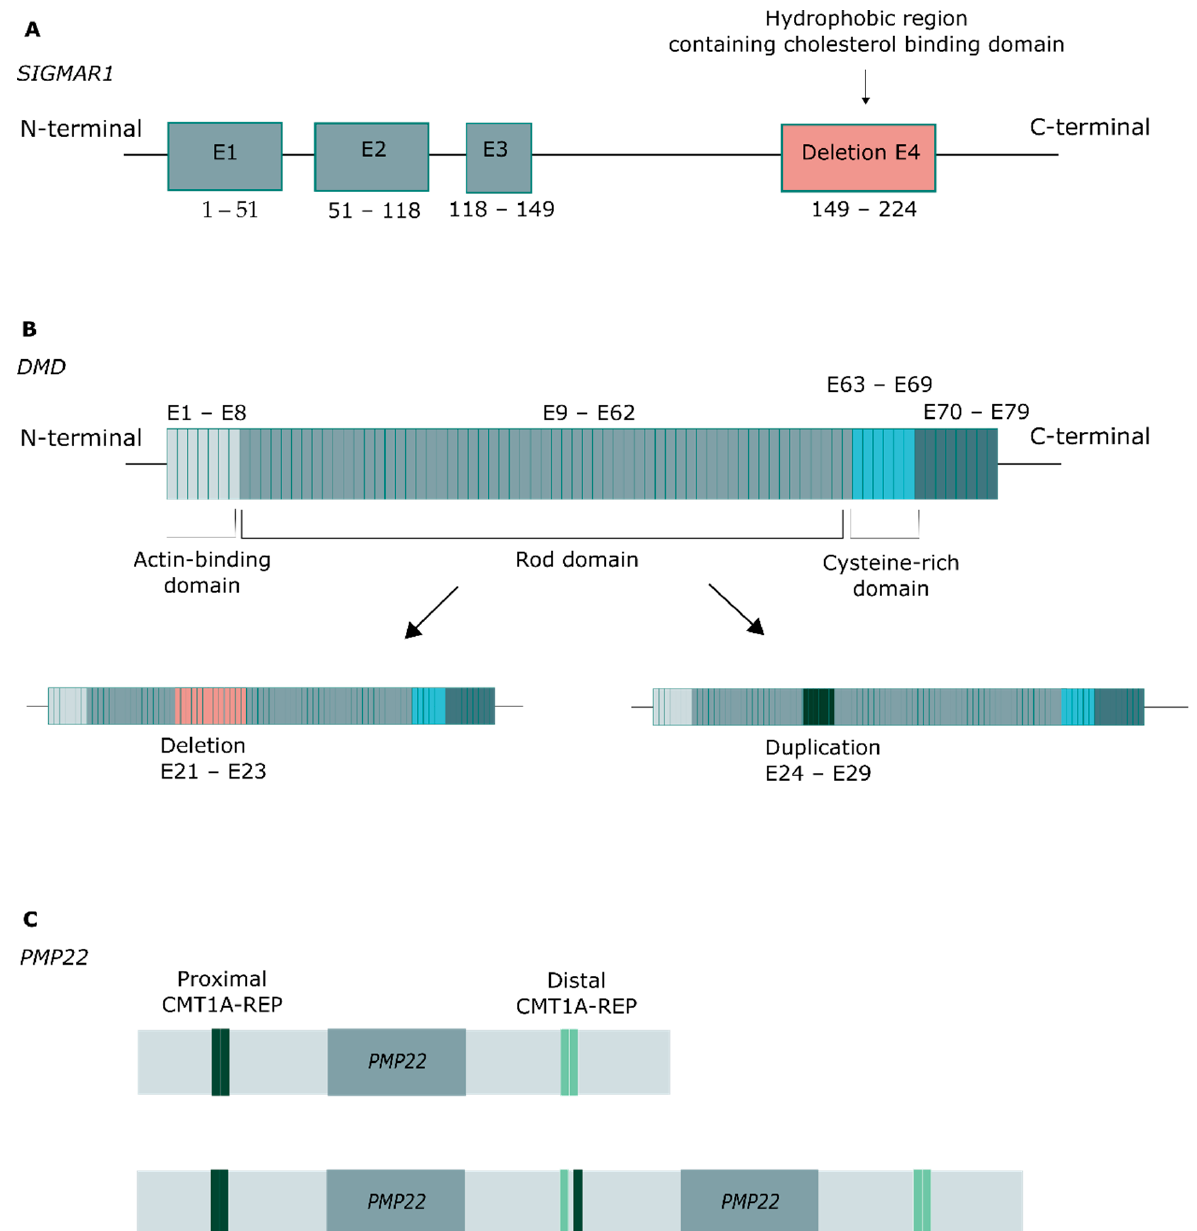
Figure 3. CNVs identified in the study population. ( A ) Exon 4 deletion in SIMGAR1, affecting the hydrophobic region. ( B ) Deletion and duplication in DMD, affecting the rod domain. ( C ) Duplication of the entire PMP22 gene, associated with Charcot–Marie–Tooth disease.